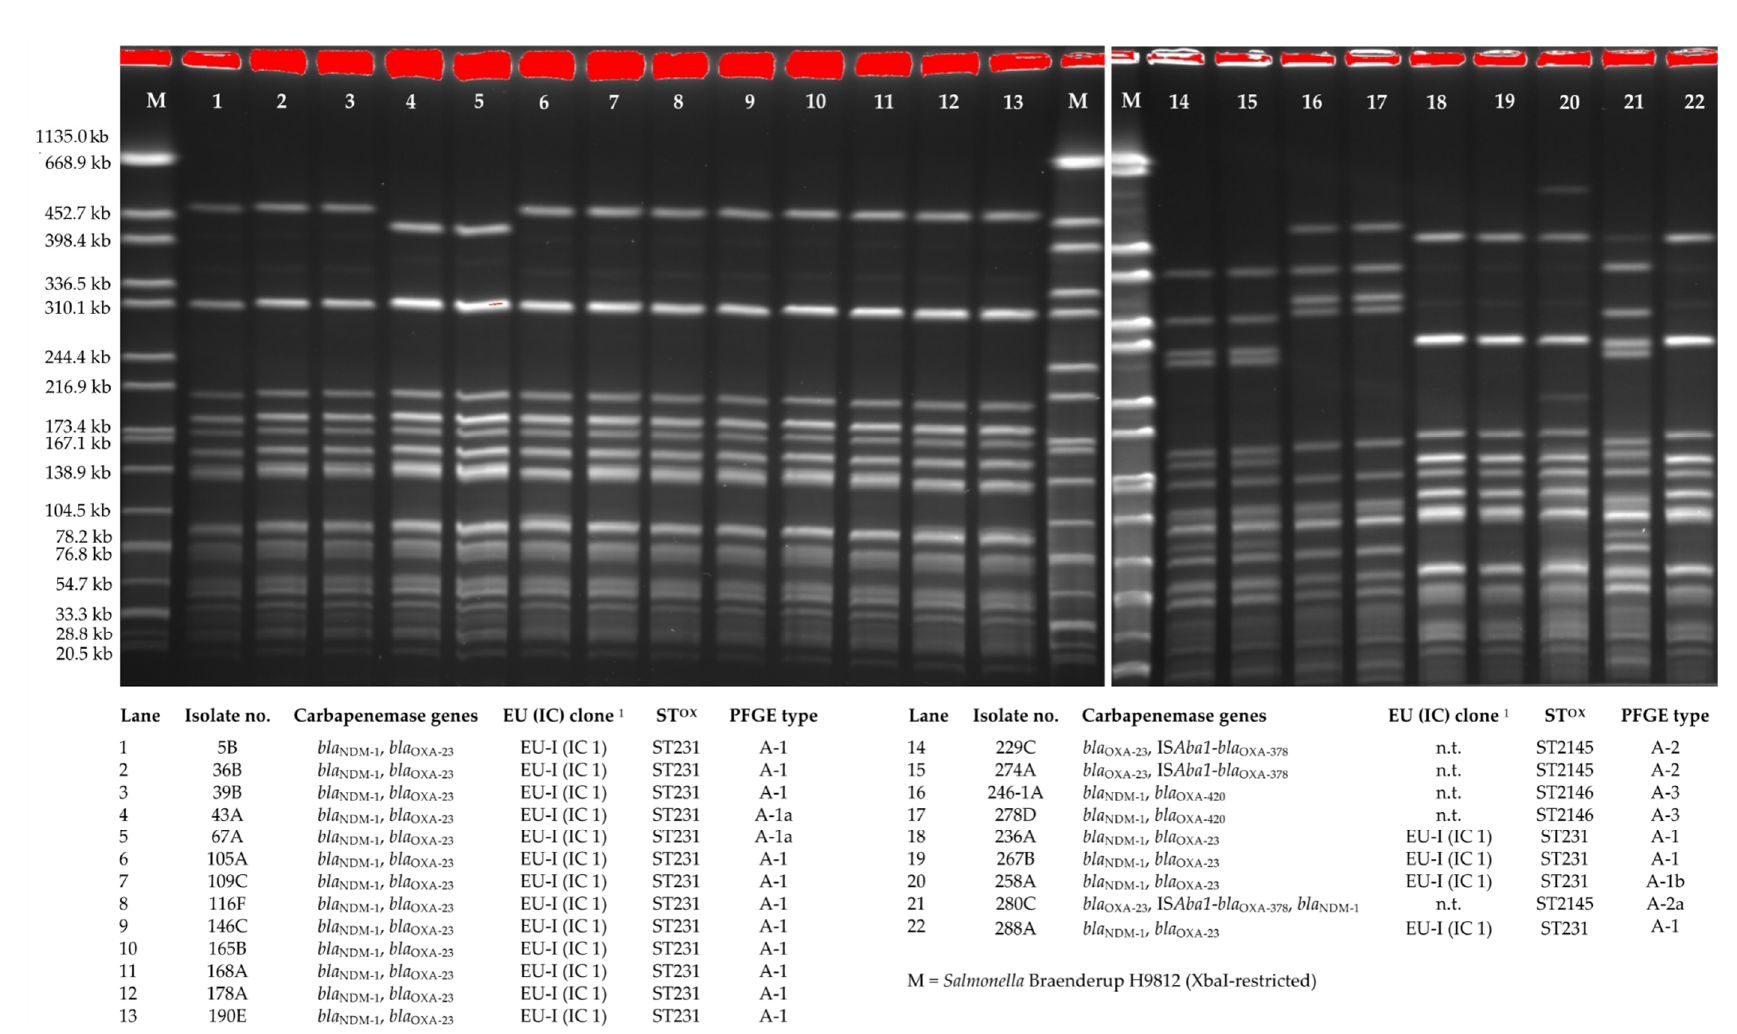
Figure 2. ApaI-macrorestriction and pulsed-field gel electrophoresis of 22 carbapenem-resistant A. baumannii isolates from wound infections, Ghana, 2017/2018. 1 PCR Turton et al. 2007 [32]. ST OX , sequence type assigned by multilocus sequence typing (MLST Oxford scheme https://pubmlst.org/organisms/acinetobacter-baumannii, assessed on 3 August 2020); n.t. non-typeable.